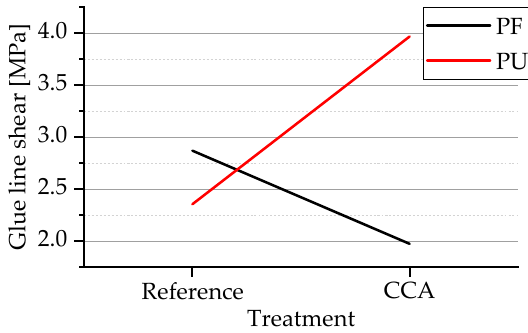
Figure 6. Interaction graphics of glue line shear.